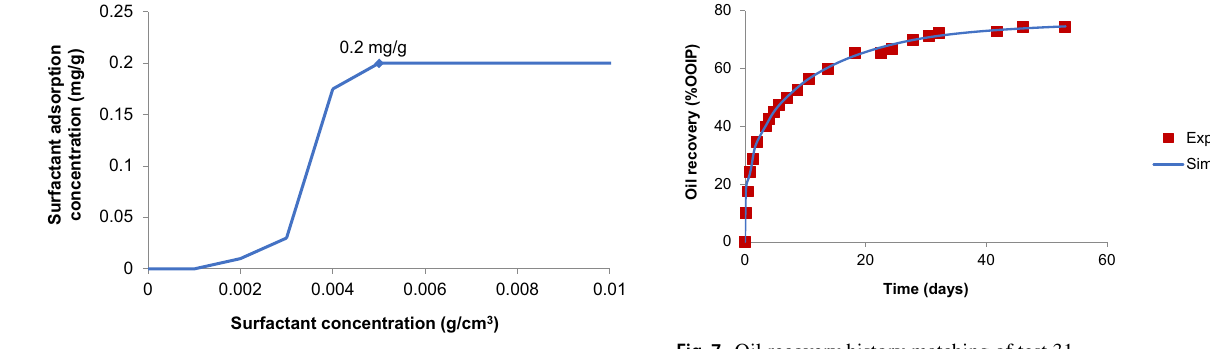
Fig. 4 Surfactant adsorption on the rock versus surfactant concentra-